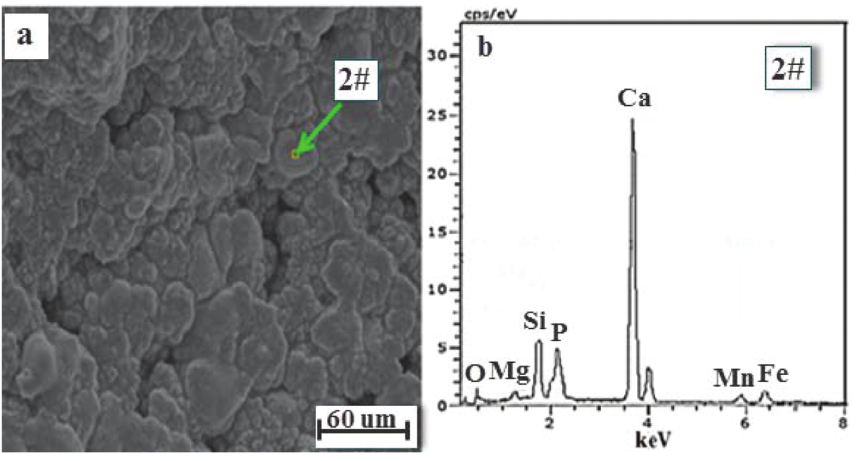
Figure 5: SEM images and EDS analysis results of the first deslagging for 2# heat: (a) SEM image, (b) EDS spectra.